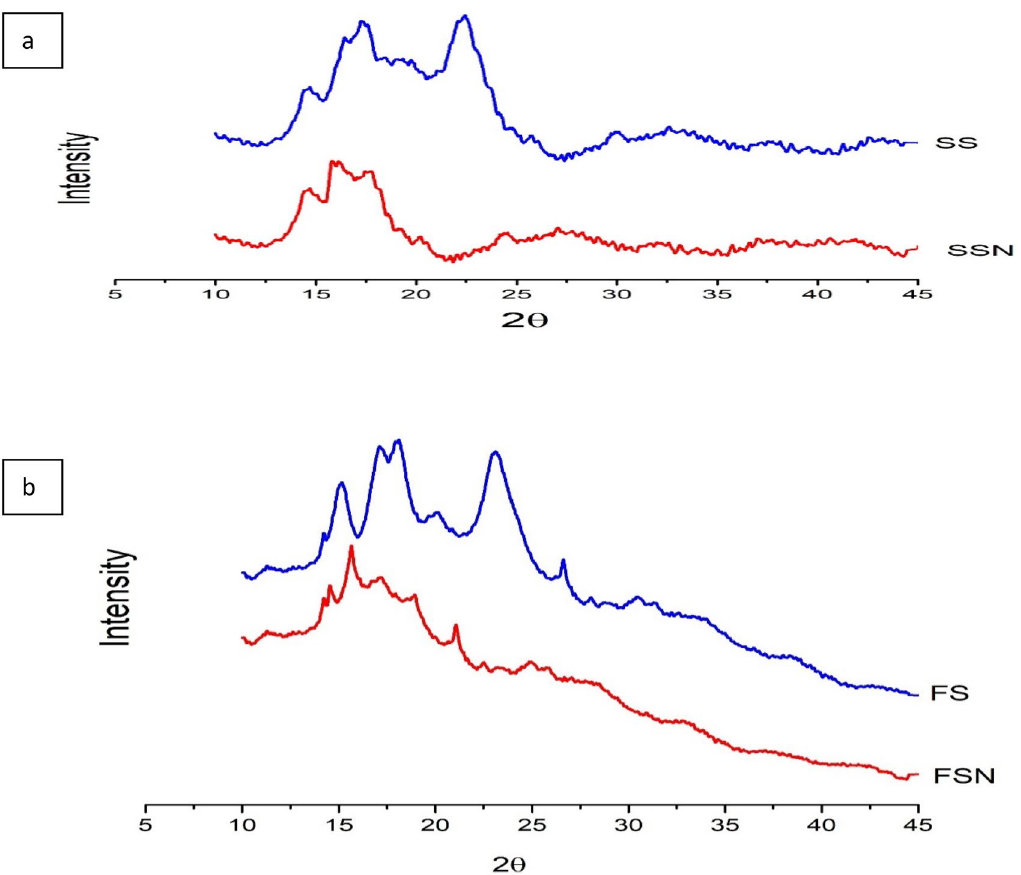
Figure 2. (a,b) Crystallinity graphs of native and nano starch samples. SS, SSN, FS & FSN represents native sorghum starch, nano sorghum starch, native foxtail starch & nano foxtail starch respectively.